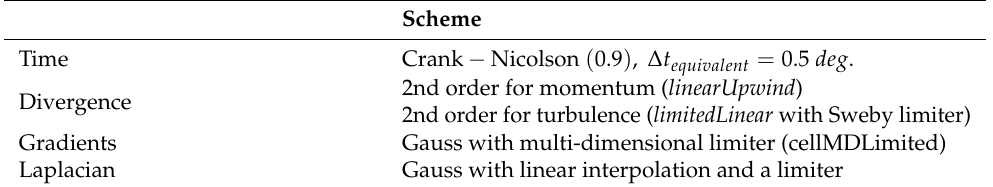
Table 3. Adopted discretization